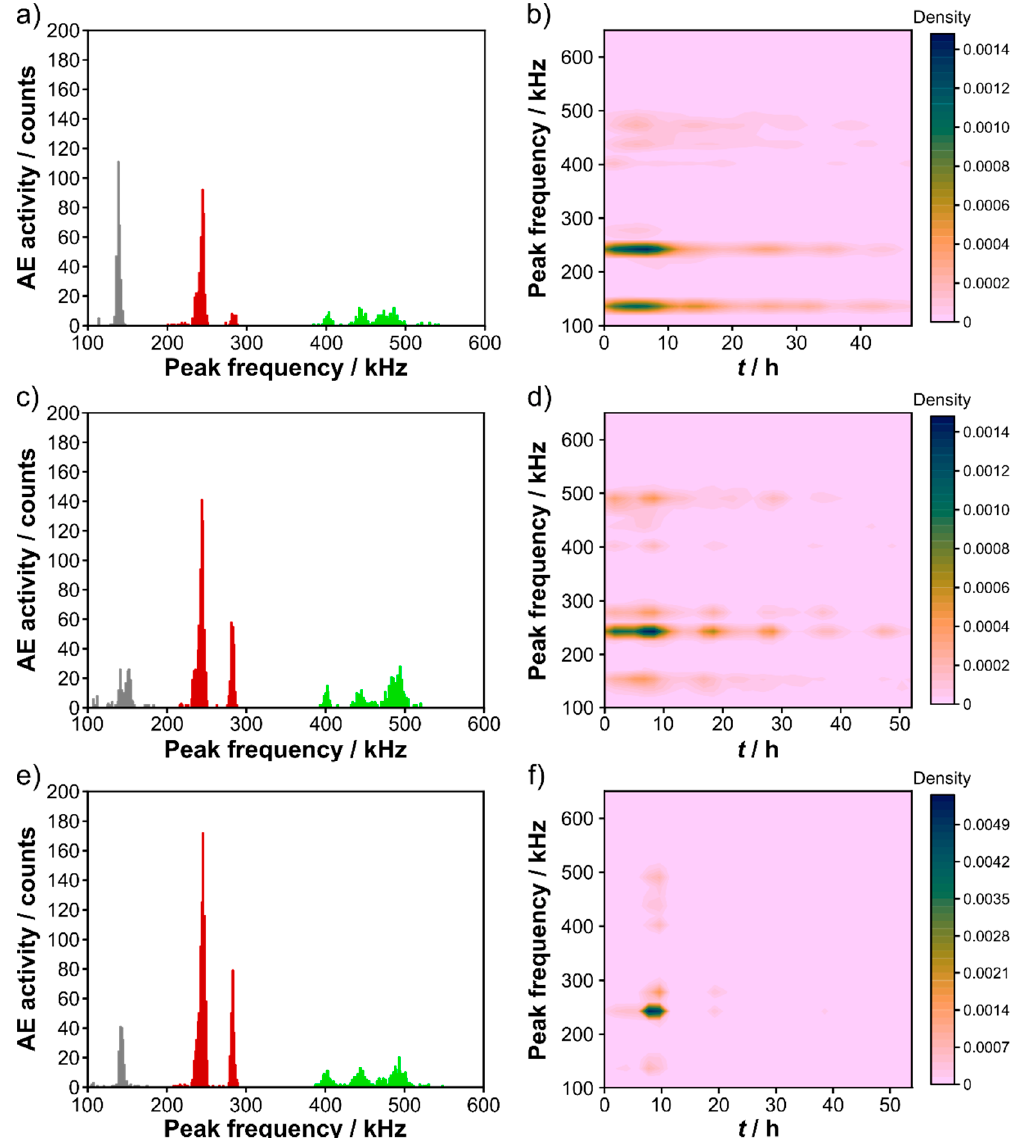
Figure 4. ( a , c , e ) Peak-frequency histograms of the AE signals (AE 1 = 100–200 kHz in gray, AE 2 = 200–300 kHz in red and AE 3 = 300–600 kHz in green) detected over the first five cycles in LiHEOF|Li cells cycled at 25 °C and C/10 rate and ( b , d , f ) corresponding contour plots of the hit density versus the time and peak frequency. ( a , b ) 2.0–4.6 V, ( c , d ) 2.0–4.8 V and ( e , f ) 2.0–5.0 V vs. Li + /Li.